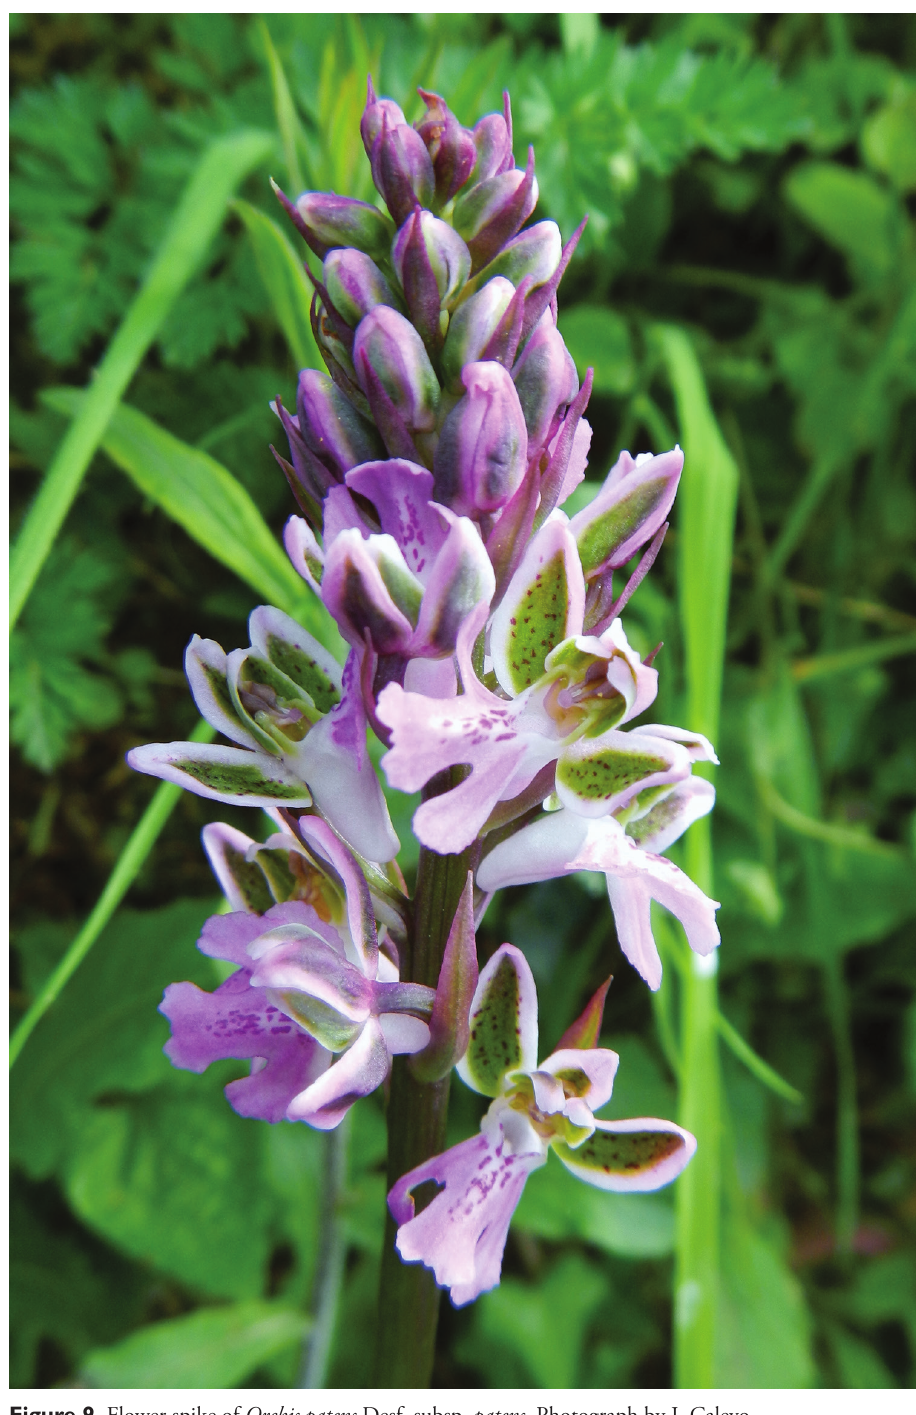
Figure 9. Flower spike of Orchis patens Desf. subsp. patens . Photograph by J.